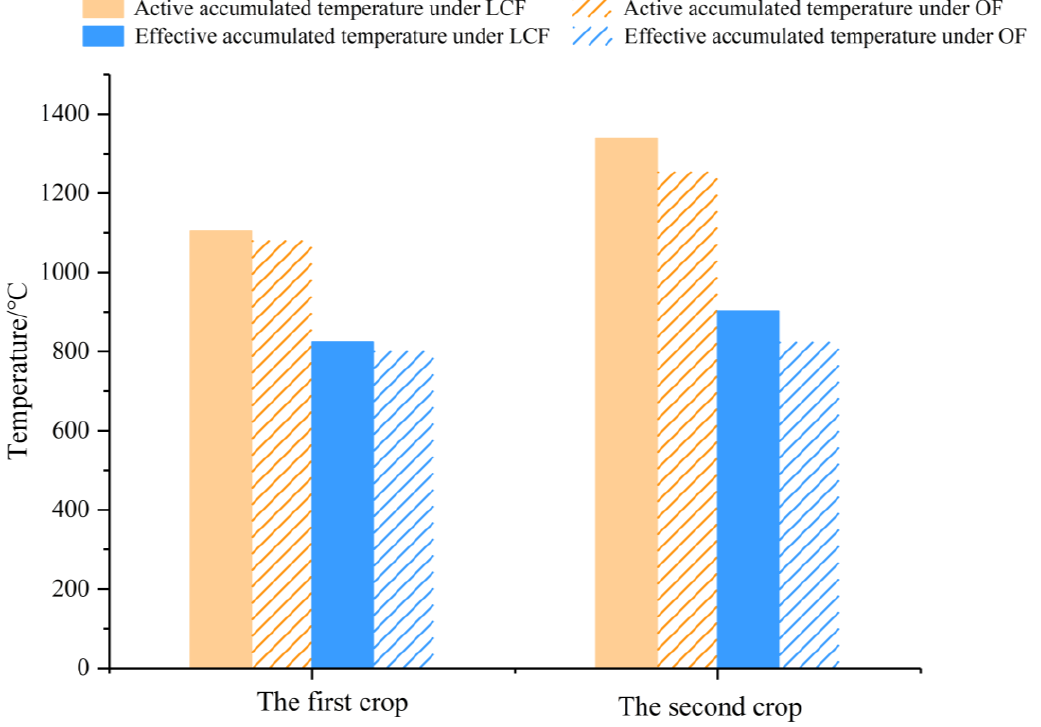
Figure 12. Effect of light conversion film (LCF) and ordinary film (OF) on accumulated temperature in greenhouse under different crops. (Note: Active accumulated temperature refers to the sum of daily active temperatures in a certain period of time or growing season of crops. Usually, the daily average temperature in the duration of more than or equal to 10 ◦ C is accumulated to obtain the total temperature, which is called active accumulated temperature. The effective accumulated temperature is the sum of the effective temperature of crops in a certain growth period or all growth periods. In this paper, the sum of 5 − 25 ◦ C in the whole growth period of crops is taken as the effective accumulated temperature).